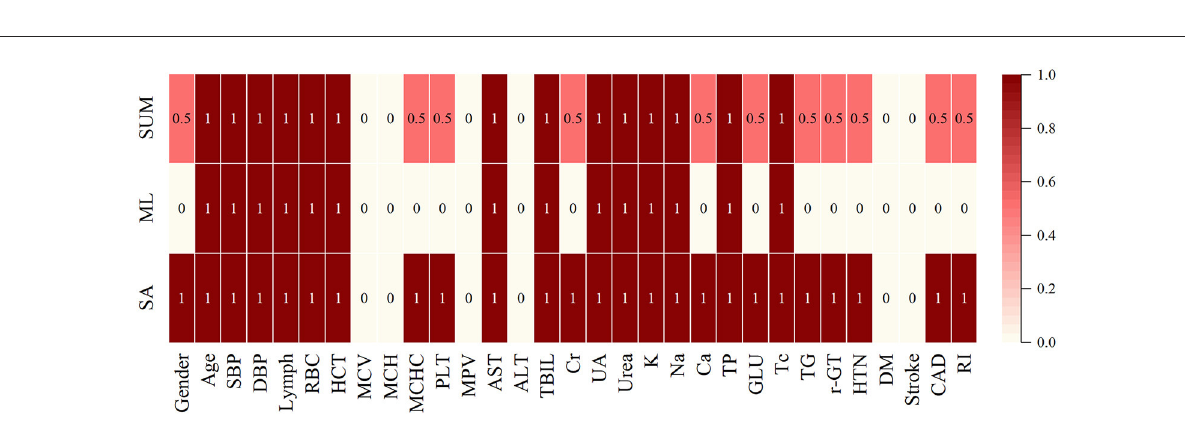
FIGURE4 Final results of feature selection by data